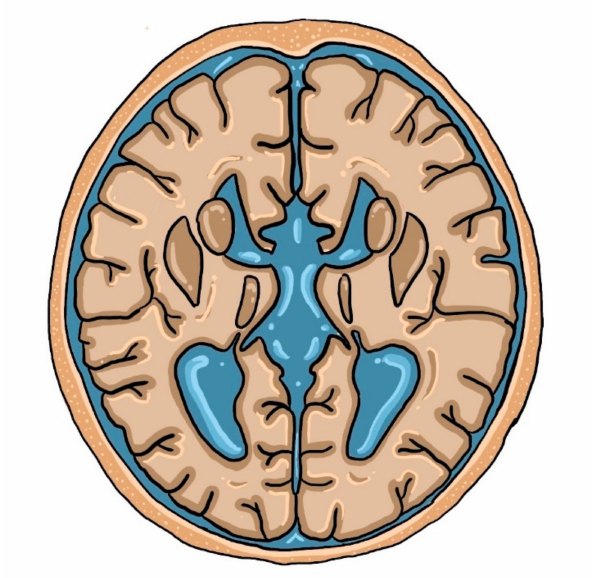
Figure 2. The ‘racing car sign’ created by enlarged